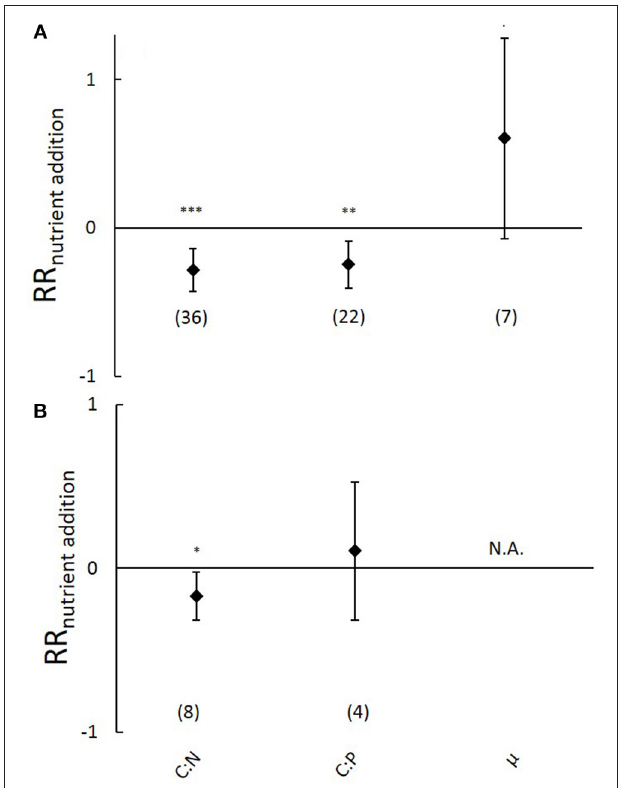
FIGURE 5 | Natural-log response ratios of carbon:nutrient stoichiometry and plant growth rates ( µ ) to nutrient (nitrogen and phosphorus) addition in (A) above- and (B) belowground biomass of submerged aquatic plants. Values represent means, error bars 95% confidence intervals and sample size is indicated between brackets. Response ratios significantly different from zero are indicated as follows: *** P < 0.001, ** P < 0.01, * P < 0.05 and · P < 0.10. N.A., indicates that data were not available.